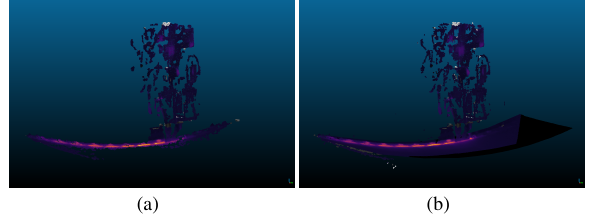
Figure 5. Exemplary point cloud from one stereo pair with color coded thermal information (a), and an additional CAD object model